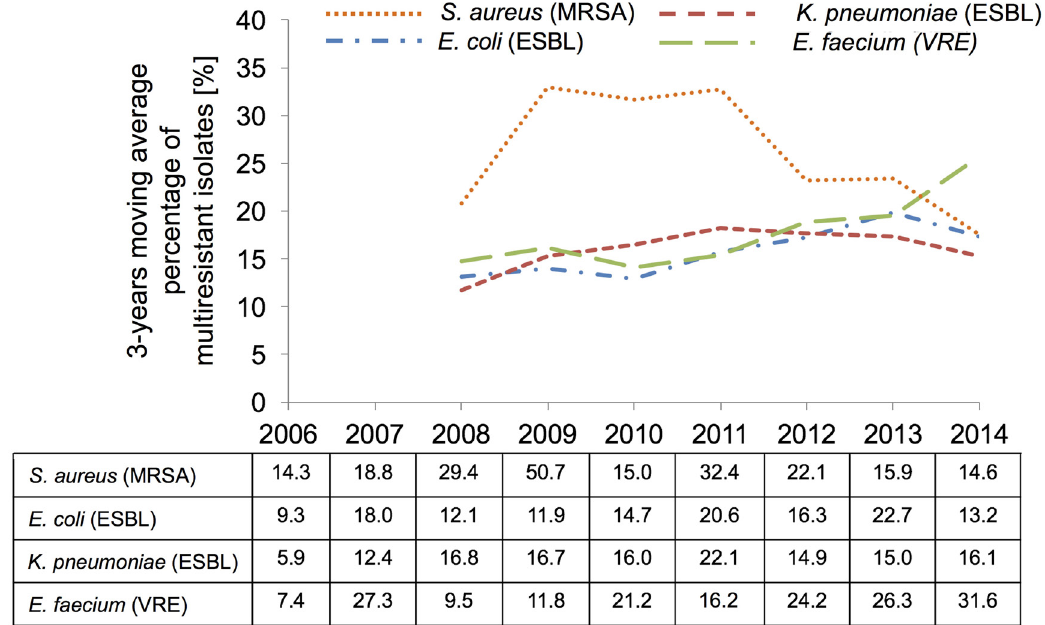
Figure 1: Percentages (%) of multiresistant isolates per total number of isolates for major pathogen species by year of isolation. Annual rates (table) and 3-years moving averages (diagram) are